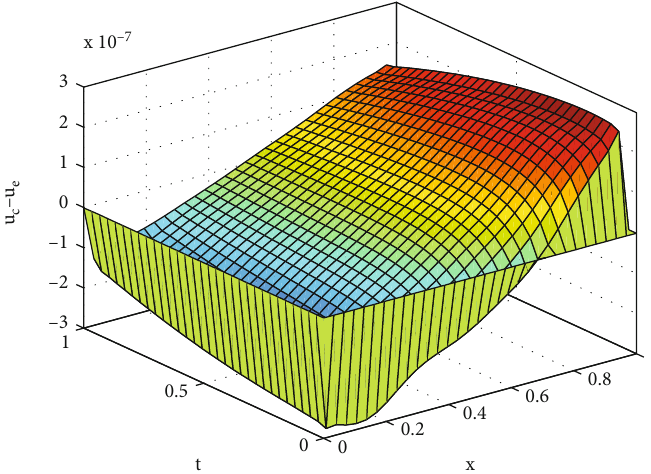
Figure 7: Errors of equidistant nodes for LBRCM with m = n = 31, d Table 9: Errors of the LBRCM with d